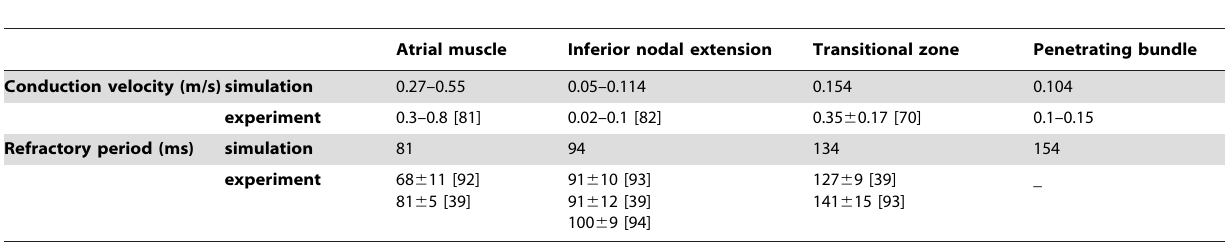
Table 3. Measurements of conduction velocity and refractory period of atrial muscle and AVN from the cellular automaton model and experiment.